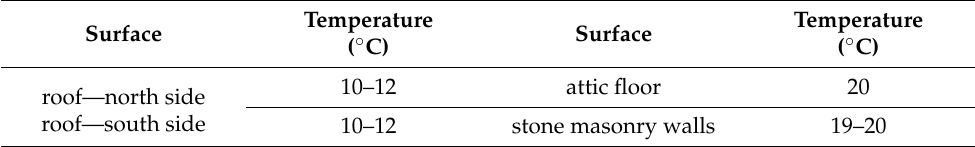
Table 8. Surface temperatures at 2:00 a.m. obtained from BPS simulation.